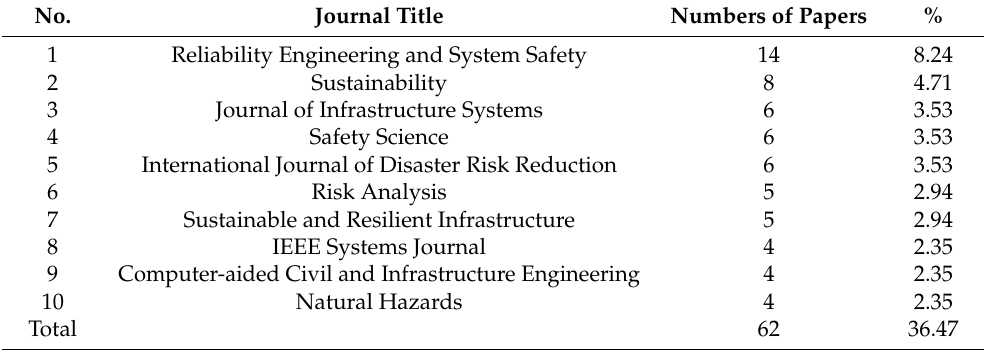
Table 2. Top 10 journals publishing infrastructure resilience papers.